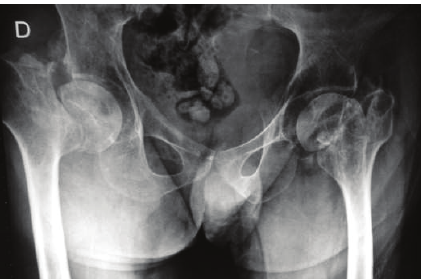
Figure 1: Anteroposterior both-hip radiograph showing bilateral Garden IV femoral neck fracture.